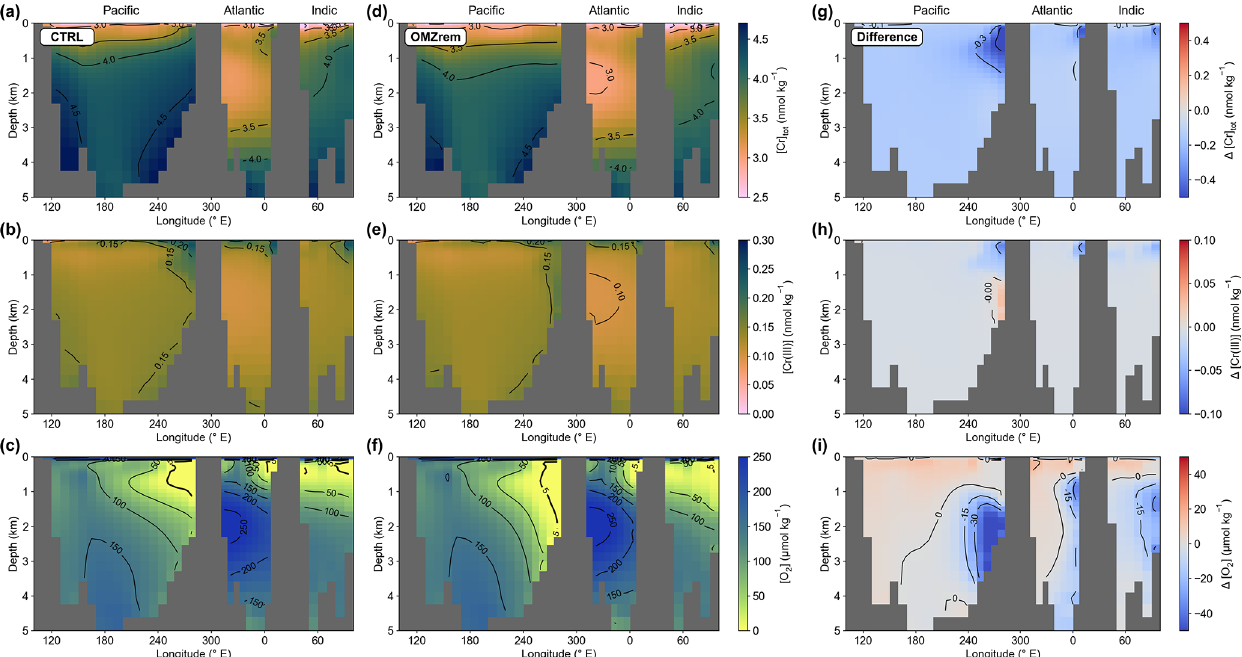
Figure 8. Total Cr (a, d, g) , Cr(III) (b, e, h) , and O 2 concentrations (c, f, i) along an east–west section at the Equator for the control run (a–c) , simulation OMZrem (d–f) , and the difference between both (OMZrem minus CTRL) (g–i) .